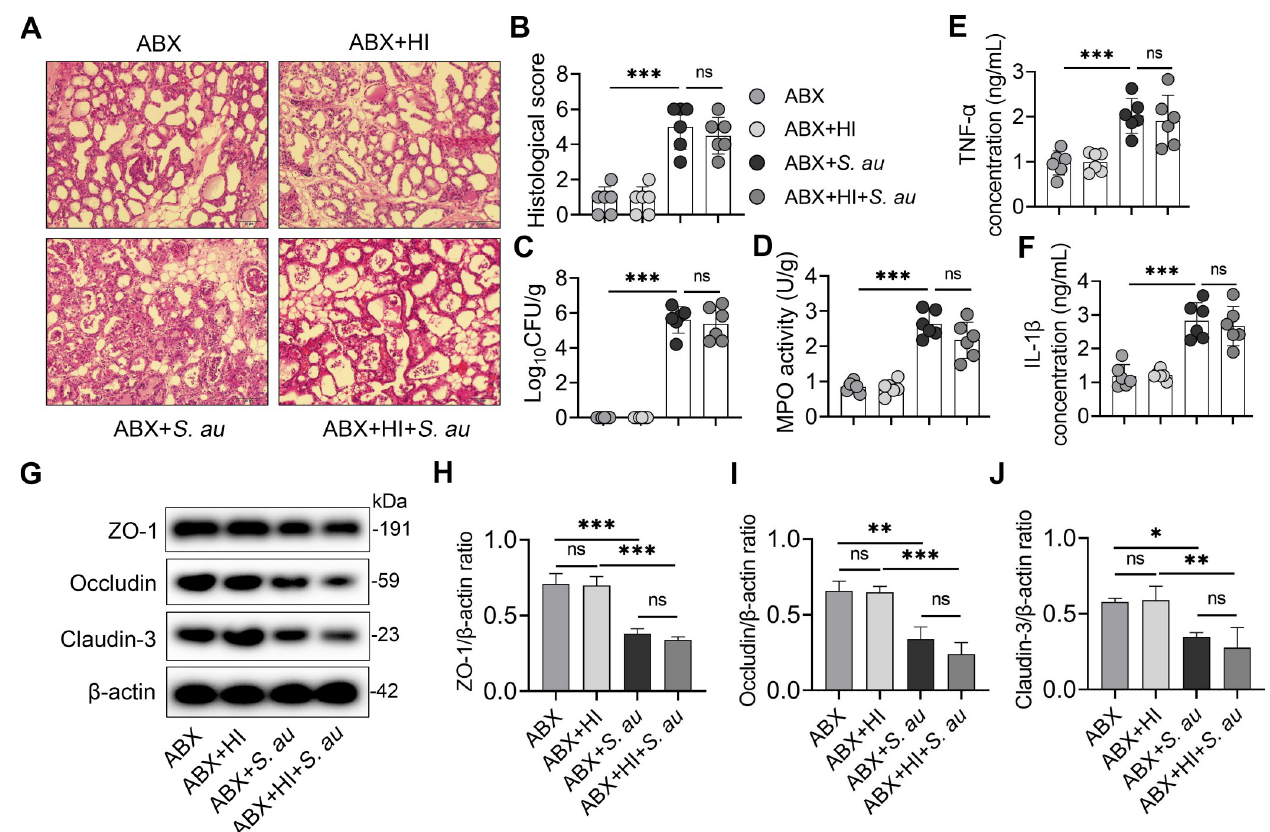
Fig 3. Depletion of the gut microbiota impairs HI diet-mediated protective effects on S . au -induced mastitis in mice. Mice were treated with a control diet supplemented with or without 20% inulin for three weeks under the condition of gut microbiota depletion by a cocktail of antibiotics (ABX) followed by S . au -induced mastitis (n = 6 per group). A . Representative H&E-stained images of the mammary glands from different treatment groups (scale bar, 50 μ m). B . Histological score of the mammary gland based on H&E-stained sections (n = 6). C . Mammary bacterial burden from the indicated mice (n = 6). D-F . Inflammatory markers including MPO activity ( D ), TNF- α ( E ) and IL- β ( F ) from the indicated groups (n = 6). G . Representative images of mammary TJ proteins, including ZO-1, Occludin and Claudin-3, by western blotting. H-I . Relative intensity of TJ proteins including ZO-1 ( H ), Occludin ( I ) and Claudin- 3 ( J ), using β -actin as an endogenous control. Data are presented as the means ± SD ( B-F , H-J ) and one-way ANOVA was performed for statistical analysis ( B-F , H-J ). � p < 0.05, �� p < 0.01 and ��� p < 0.001 indicate significant